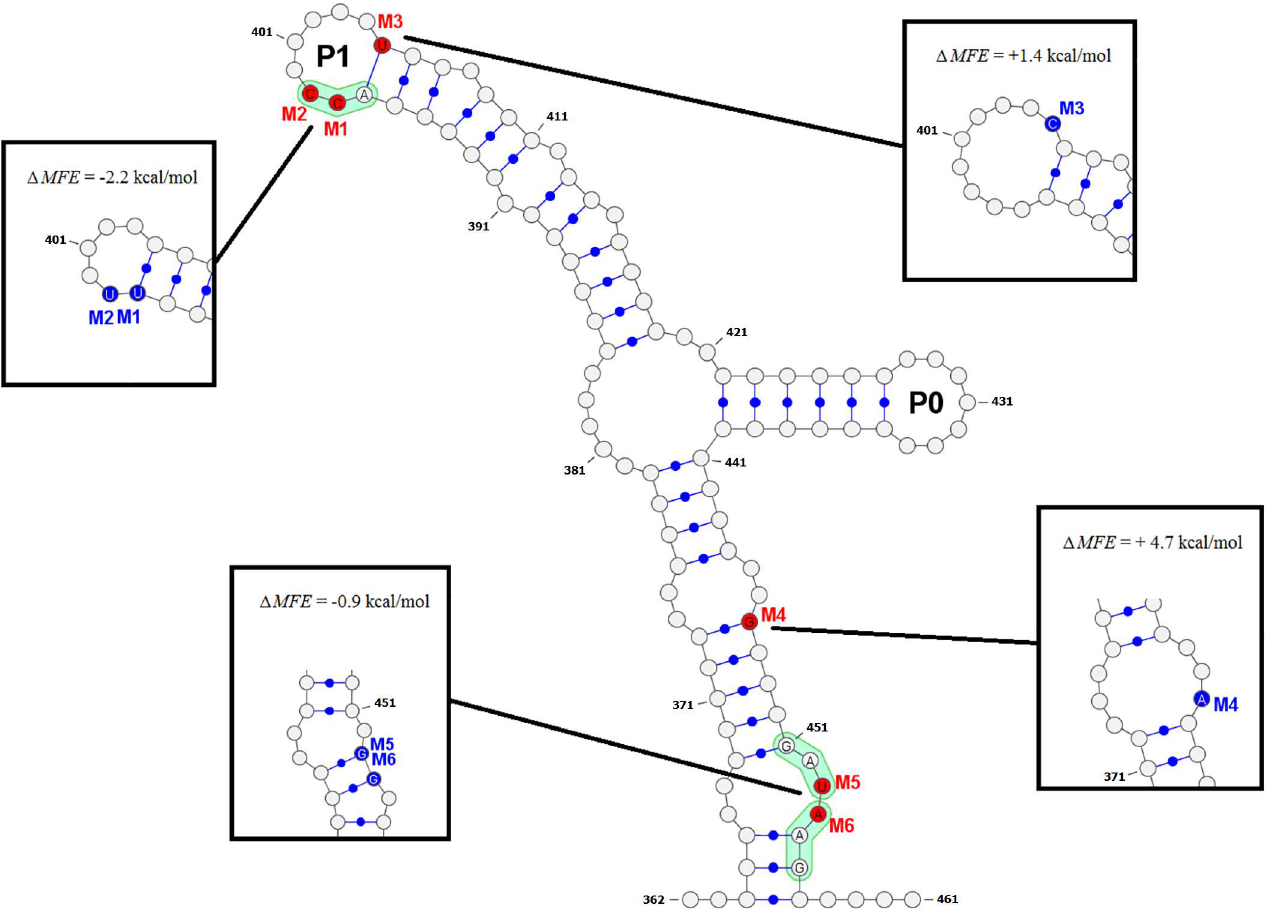
Fig 2. Dominant (wildtype) secondary structure for R2 and structural variations corresponding to hypothetical mutants. The green curves enclose codon triplets. The four rectangle insets show local rearrangements of the RNA secondarystructures resulting from four mutations. Mutants are labeledin blue and designatedM1M2, M3, M4, and M5M6. Major secondarystructural changes caused by mutations are shown inside corresponding squares.